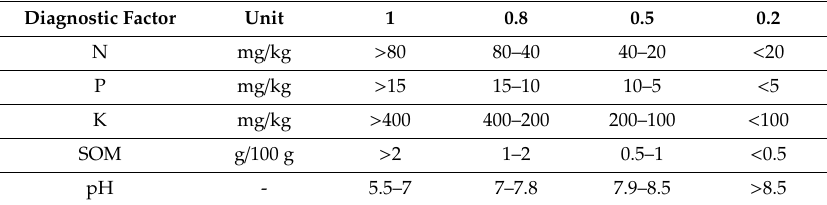
Figure 2. The flowchart methodology of soil nutrient status at Wadi El-Garawla.